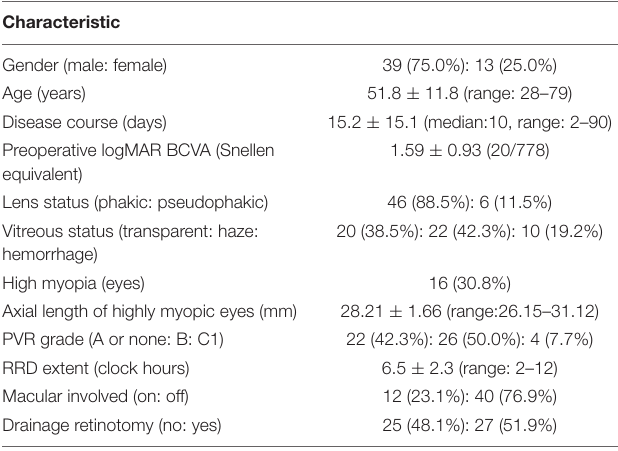
TABLE 1 | Clinical characteristics of 52 eyes undergone 25-G PPV with air tamponade for RRD with inferior breaks.